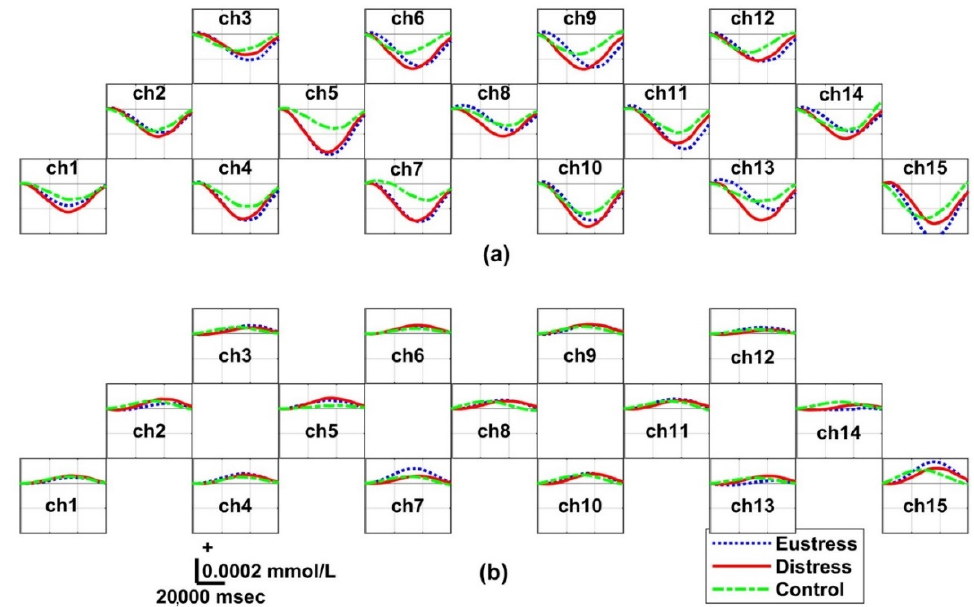
Figure 6. Grand averaged temporal hemodynamic oscillation changes within the interval of each epoch in Session 1 for the eustress, distress, and control groups: ( a ) oxygenated hemoglobin ( ∆ HbO) and ( b ) reduced hemoglobin ( ∆ HbR). The blue dotted, red, and green dotted lines correspond to the eustress, distress, and control groups, respectively. These data show the highest brain oscillation in the distress group, followed by the eustress group and control group.